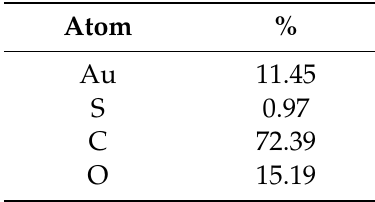
Table 2. Atomic abundance percentages of gold nanorods (AuNRs) / LA,GG measured by X-ray photoelectron spectroscopy (XPS) analysis.